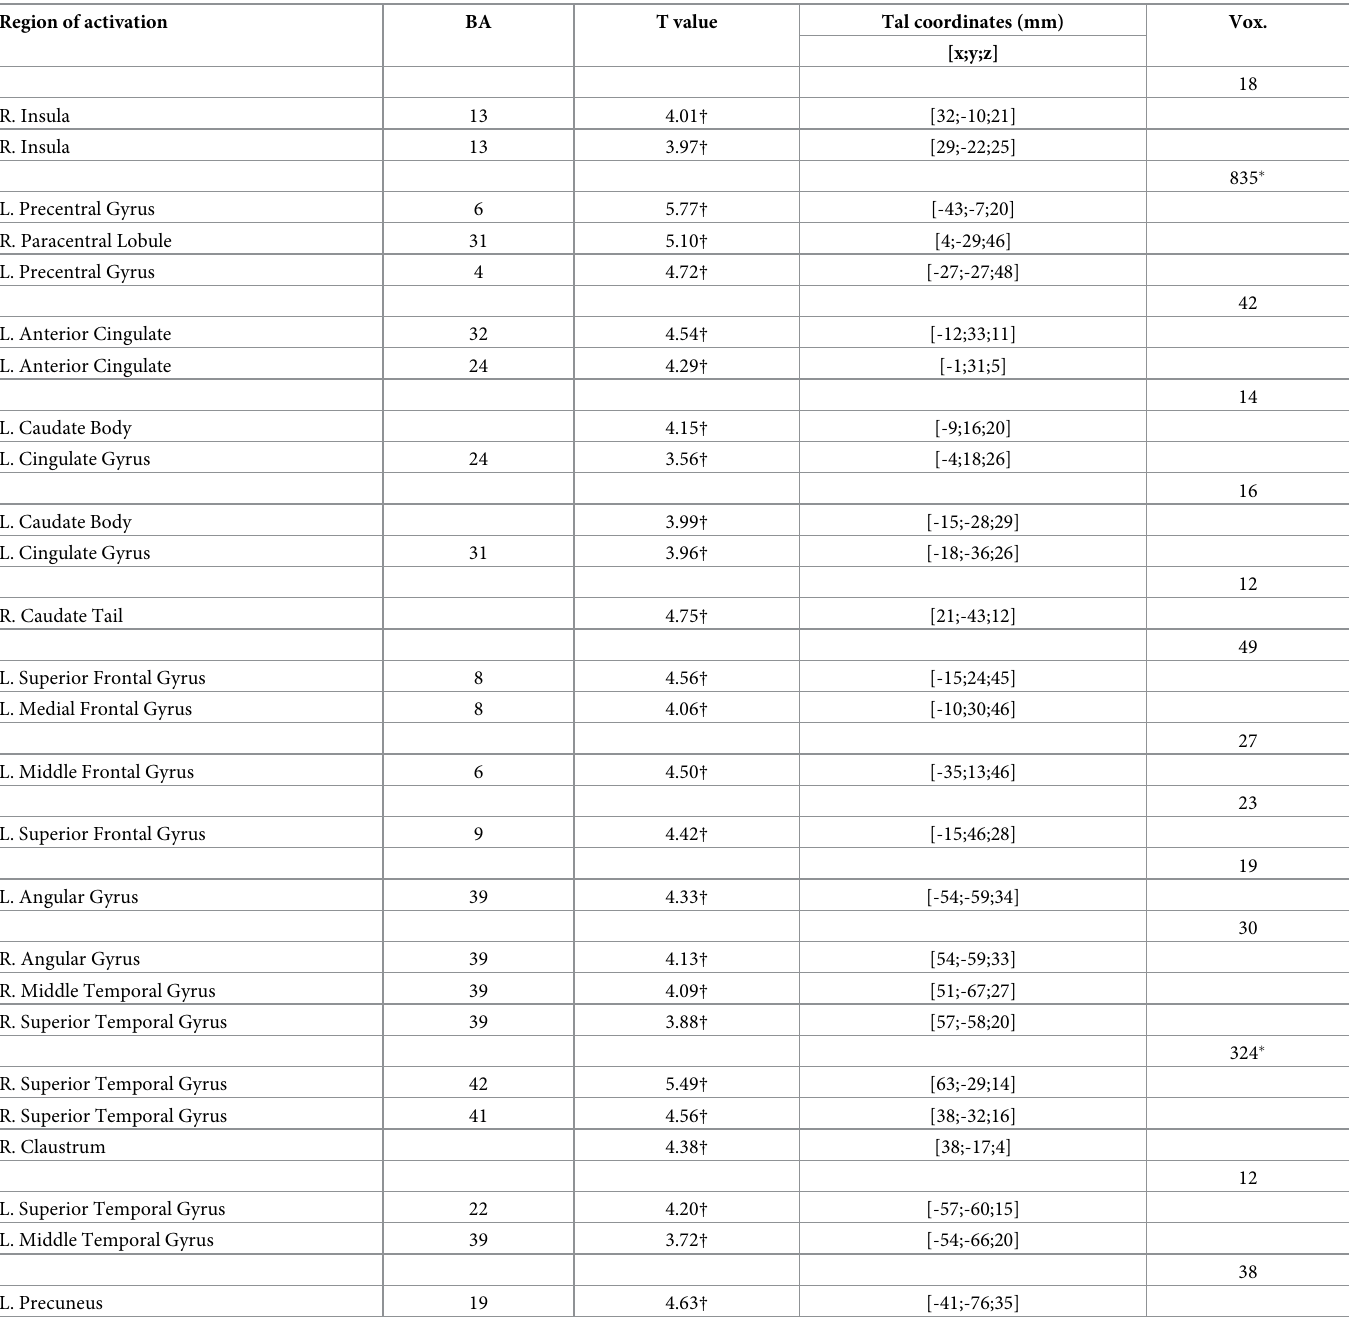
Table 4. Activations associated with accumulation in whole-brain analysis. Region of